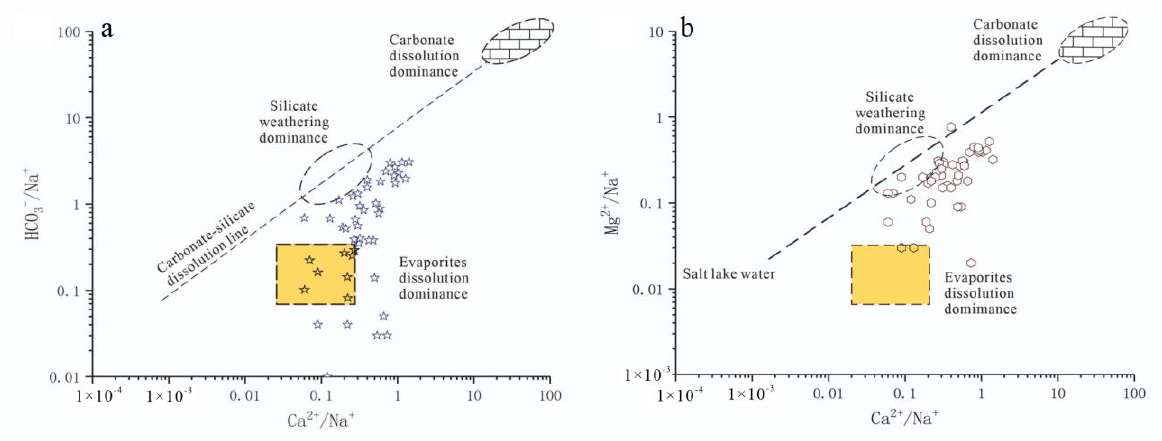
Figure 11. Weathering control diagram of different types of rocks in the research area. Bivariate plots of Na + normalized molar ratios Ca 2+ /Na + against HCO 3 − /Na + ( a ) and Mg 2+ /Na + ratios ( b ) to examine the dominant mineral weathering in the area;